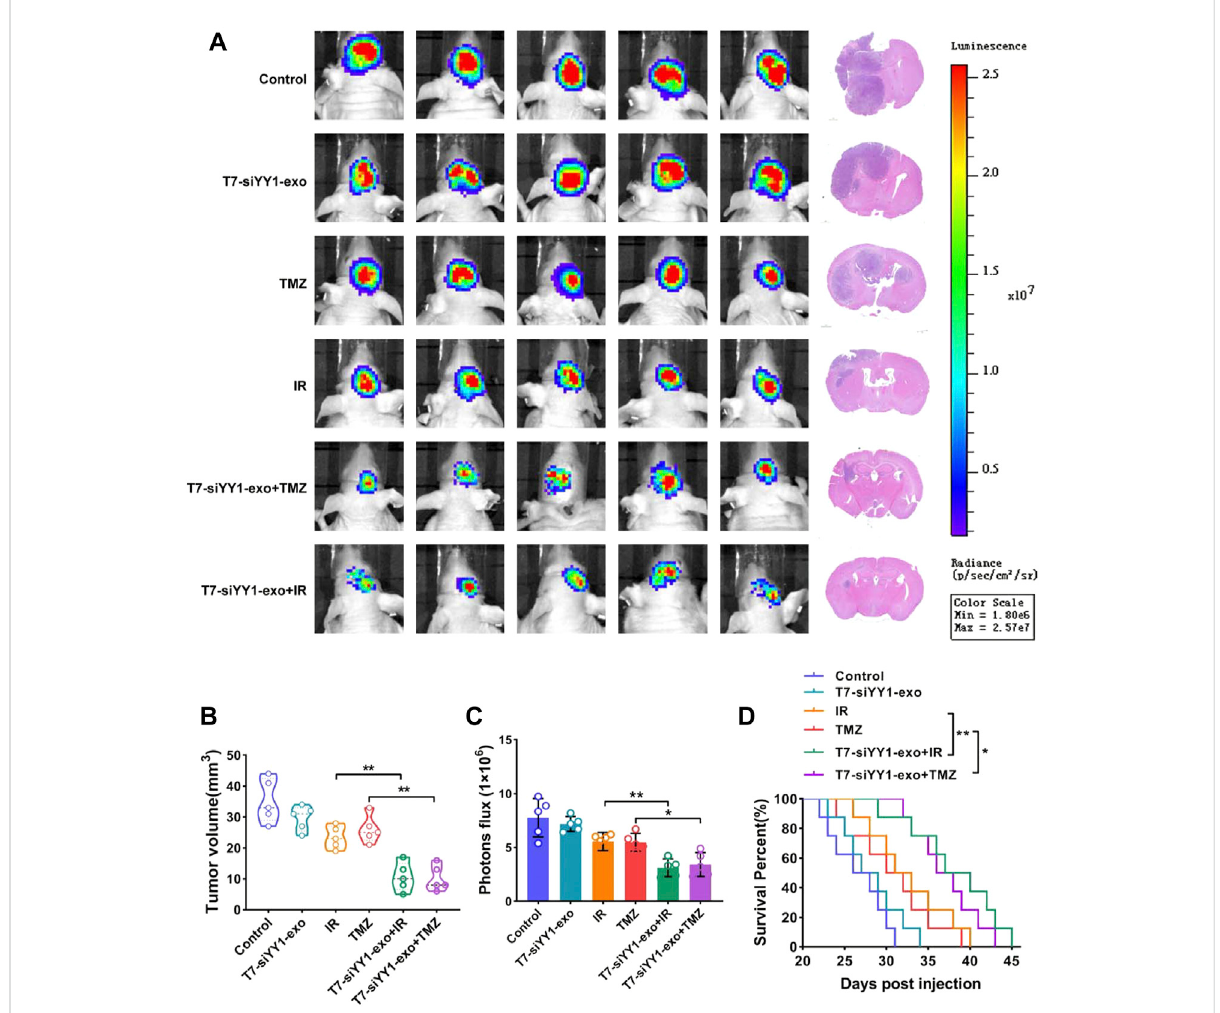
FIGURE 6 Anti-tumor ef fi ciencyofT7-siYY1-exoinvivo. (A) Left, representativeimages of invivo orthotopicGBMbioluminescence. Right,Representative images of H&E staining. Bioluminescence images were captured by IVIS on day 21 in all groups. After mice sacri fi ce, brain tissue samples were obtained for HE staining. (B) The tumor volume was calculated using a modi fi ed ellipsoid formula. Brain tissue samples were obtained after mice sacri fi ce. p values are displayed as * p ≤ 0.05, ** p ≤ 0.01, *** p ≤ 0.001. (C) Quanti fi cation of the bioluminescence of xenografts derived from the luciferase-labeled LN229 cells in each group. Bioluminescence images were captured by IVIS on day 21 in all groups. p values are displayed as * p